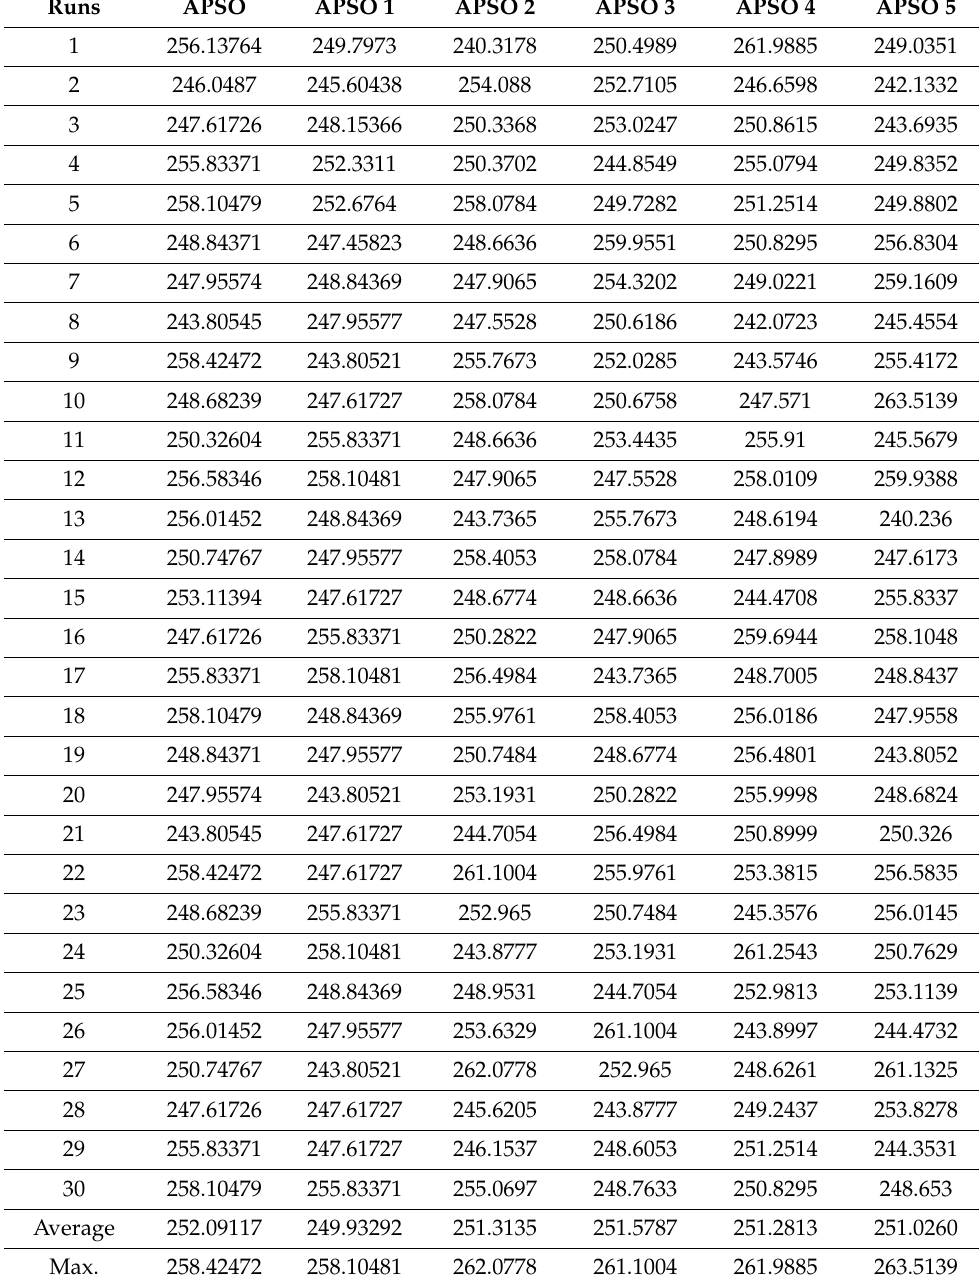
Table 17. APSO and its variants’ results for 1000 PHEVS (30